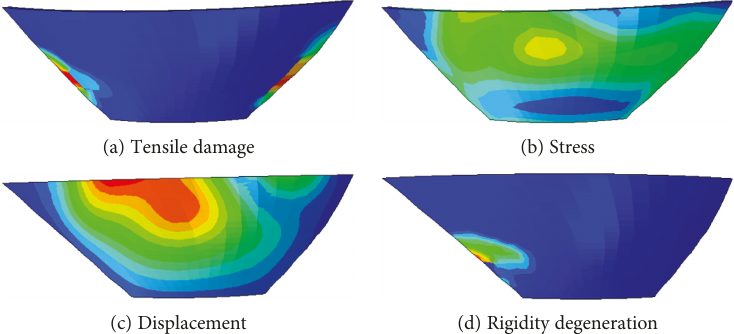
Figure 8: Dynamic response distribution of arch dam at t = 3 341 s .